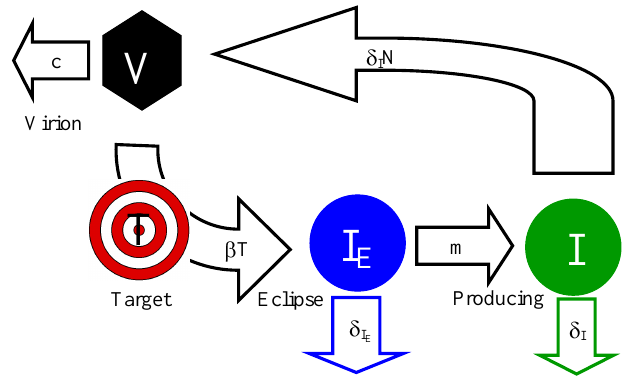
Figure 1. Interaction diagram of the extended standard mathematical model of the early dynamics of HIV/SIV. Viruses, V , infect target cells, T at a rate β and are cleared at a rate c . The target cell enters an eclipse phase, I , where it does not actively release any virions. E Cells in the eclipse phase die at a rate δ . From the eclipse phase, the cell transitions to the I E state of a productively-infected cell, I , at a rate m . Productively infected cells die at a rate δ or release infectious virions at a rate Nδ ; N is the average number of infectious virions I I produced by an infected